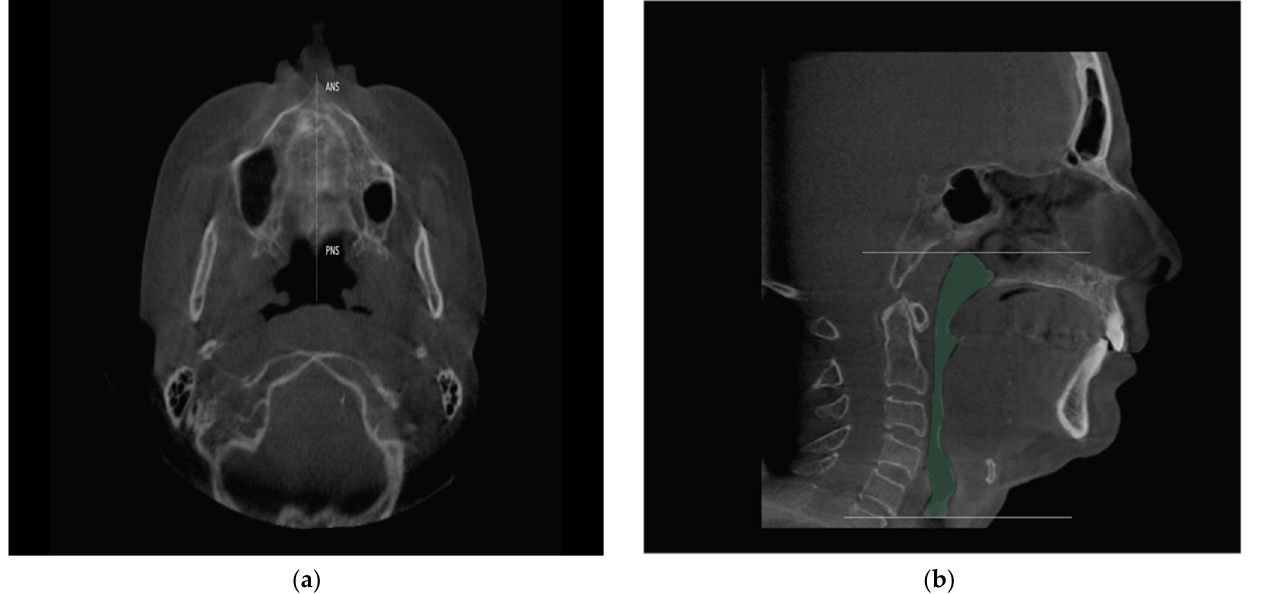
Figure 2. ( a ) Orientation of the three-dimensional reconstruction for the volumetric measurement, from the anterior nasal spine to the posterior nasal spine; ( b ) determination of the limits of the upper airway for the volumetric measurement. ANS: Anterior nasal spine; PNS: Posterior nasal spine.